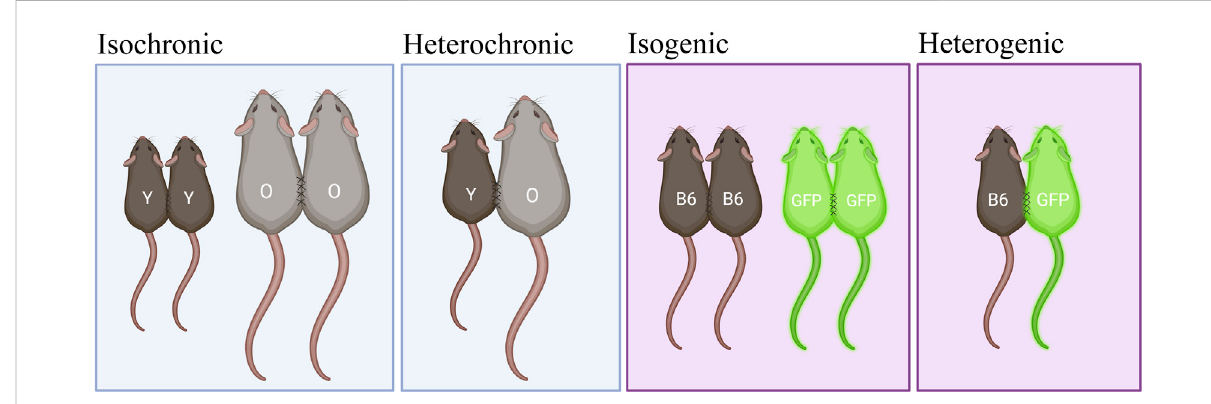
FIGURE 1 Types ofsurgical parabiosis pairs. Isochronic and isogenicpairs arecomprisedofmice ofthesame ageorstrain, respectively. Examplesinclude young-young (YY) and old-old (OO) in an aging study and B6-B6 and GFP-GFP in a study using transgenic mice. Heterochronic and heterogenic pairs differ by age or strain, respectively. Examples include young-old (YO) in an aging study and B6-GFP in a transgenic